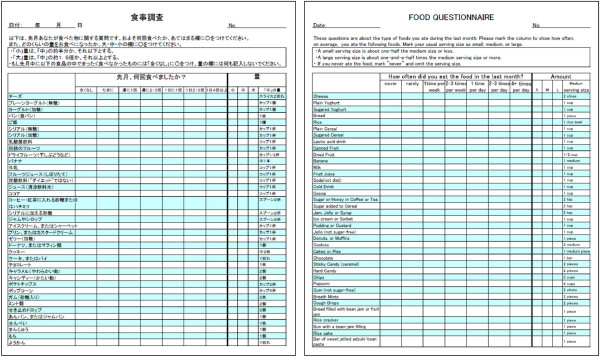
Japanese version of the food frequency questionnaire and its English translation.